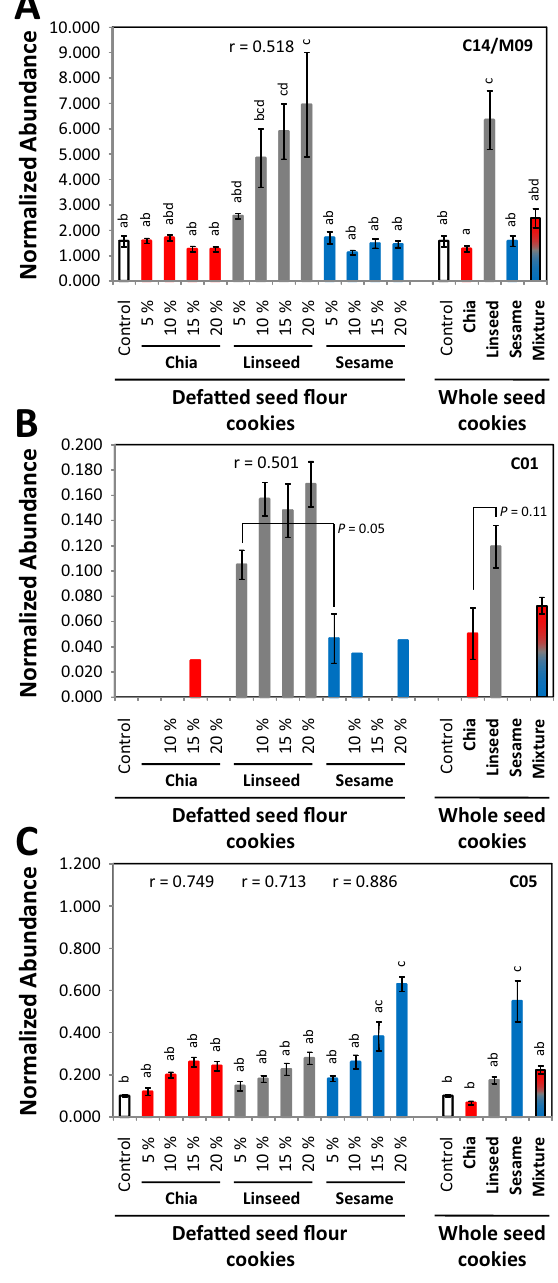
Figure 8. Characterization of linseed markers and a general seed identity marker in experimental bakery products. Non-targeted metabolite profiling analyses of polar extracts are depicted as described (Fig. 7). ( A ) Compound C14 also identified as non-processed seed marker M09: a non-identified marker compound. ( B ) Compound C01: monomethylsuccinate. ( C ) Compound C05: a pentitol with best mass spectral match to xylitol. Tukey´s test (lowercase letters) was performed, if applicable. If the compound was not detectable in control samples, exemplary t -tests are included ( P